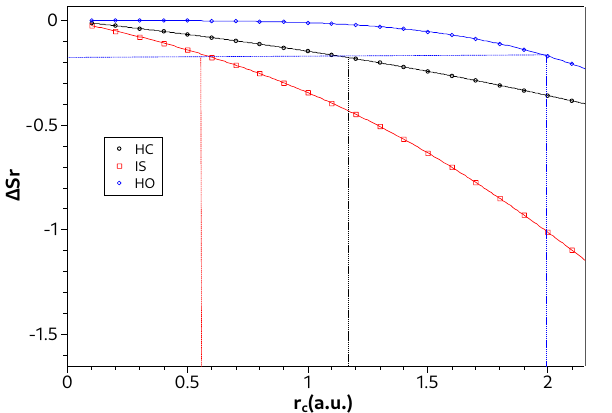
Figure 4. Values of ∆ S r in ground state as a function of r c for the hydrogen confined (HC), ion-sphere (IS), and confined harmonic oscillator (HO). The vertical lines delimit the region of strong confinement for each